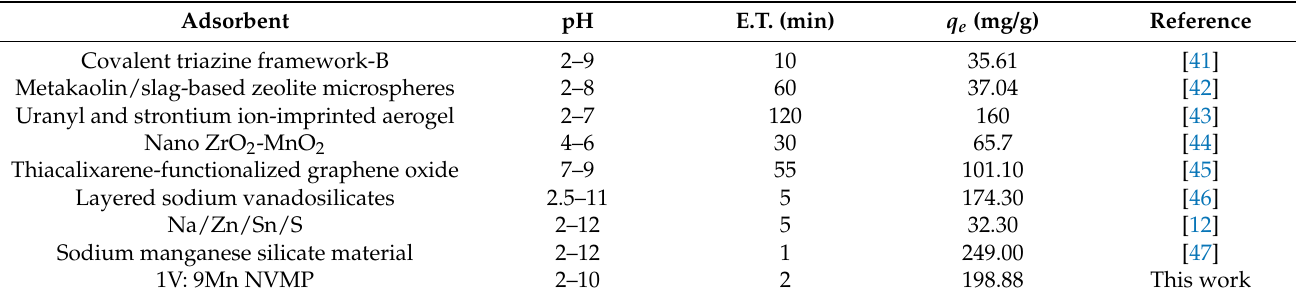
Table 2. Comparison of NVP/NMP with other adsorbents.